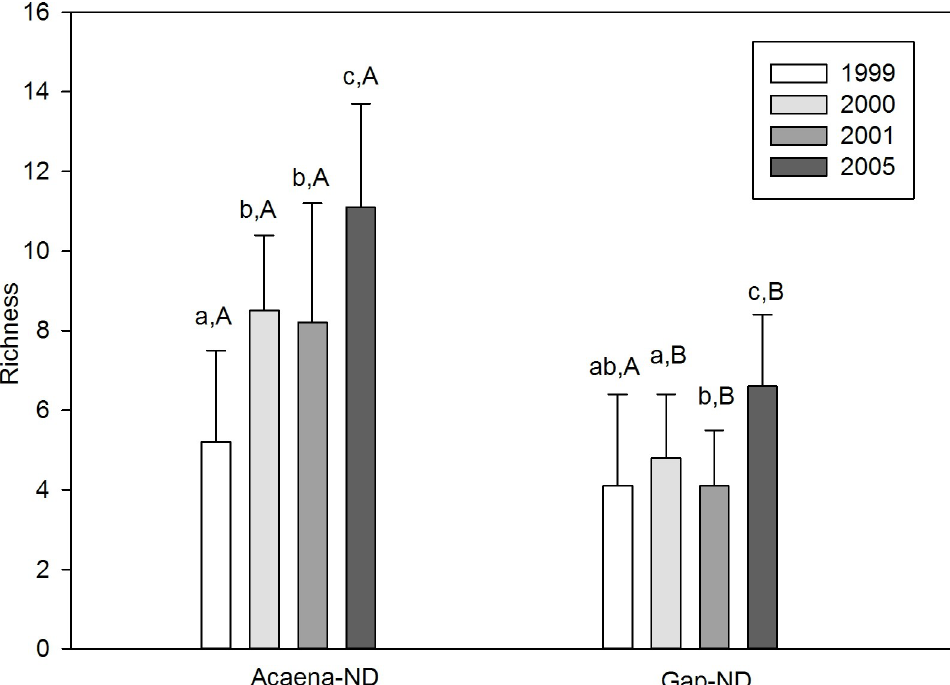
Fig 2. Species richness in Acaena-ND and Gap-ND microsites. Mean species richness ± SD in Acaena-ND and Gap- ND microsites (non-degraded grassland) in November 1999–2001, and 2005. Lower-case letters indicate significant differences between years in the same microsite. Capital letters indicate significant differences between microsites in the same year.